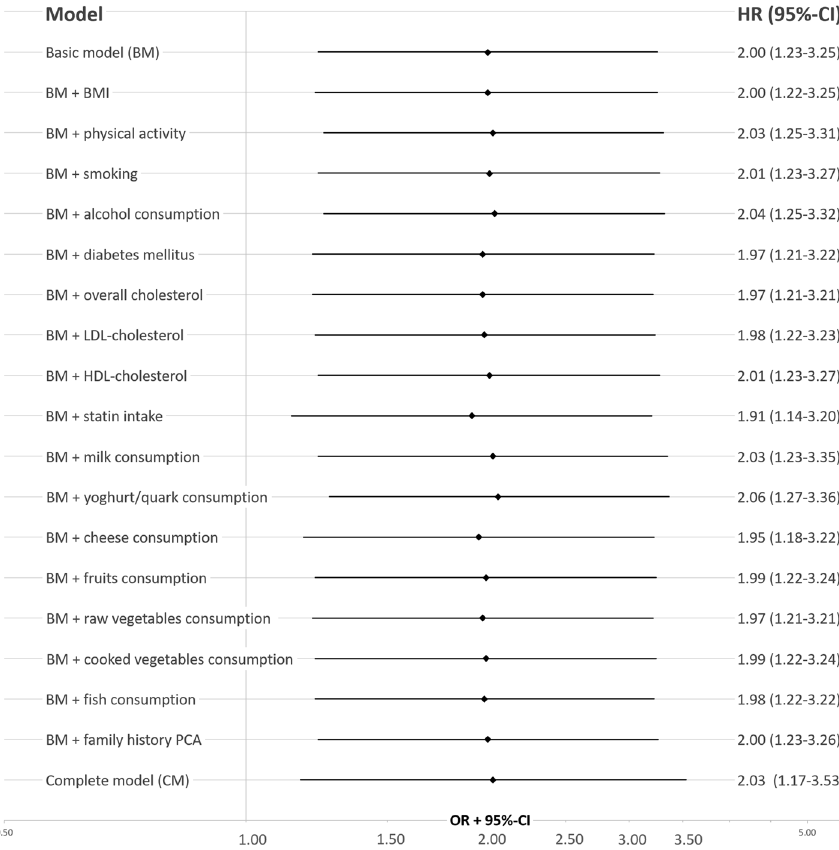
Figure 2. Hazard ratios (HR) and corresponding 95%-confidence intervals (95%-CI) for the association of monoclonal gammopathy of undetermined significance (MGUS) and incident prostate cancer (PCa), subsequently adjusted for potential risk factors. BM basic model (i.e., adjusted for age and education), [N] number of observations included in the model, BMI body mass index, LDL low density lipoprotein, HDL high density lipoprotein, full model = adjusted for age, education and all potential risk factors (except total cholesterol).